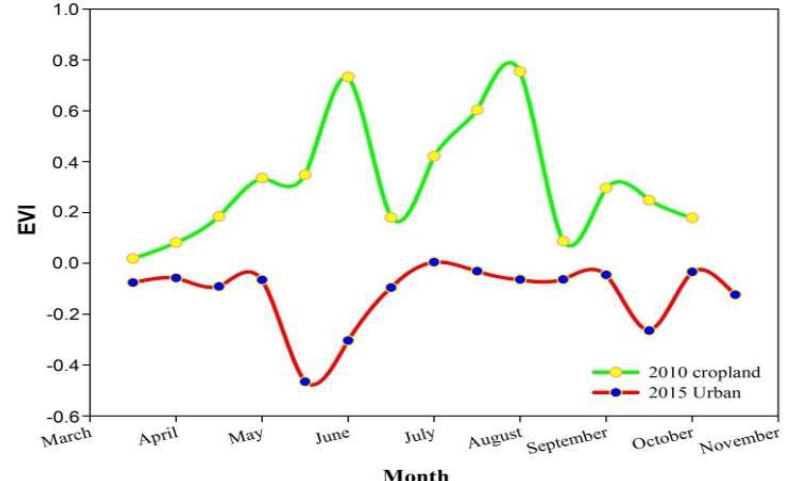
Figure 4. The phenological trajectory of cropland collected from Landsat Enhanced Thematic Mapper Plus (ETM+) time-series image in 2010 and the Enhanced Vegetation Index (EVI) curve of urban built-up from the Landsat OLI time-series image in 2015.